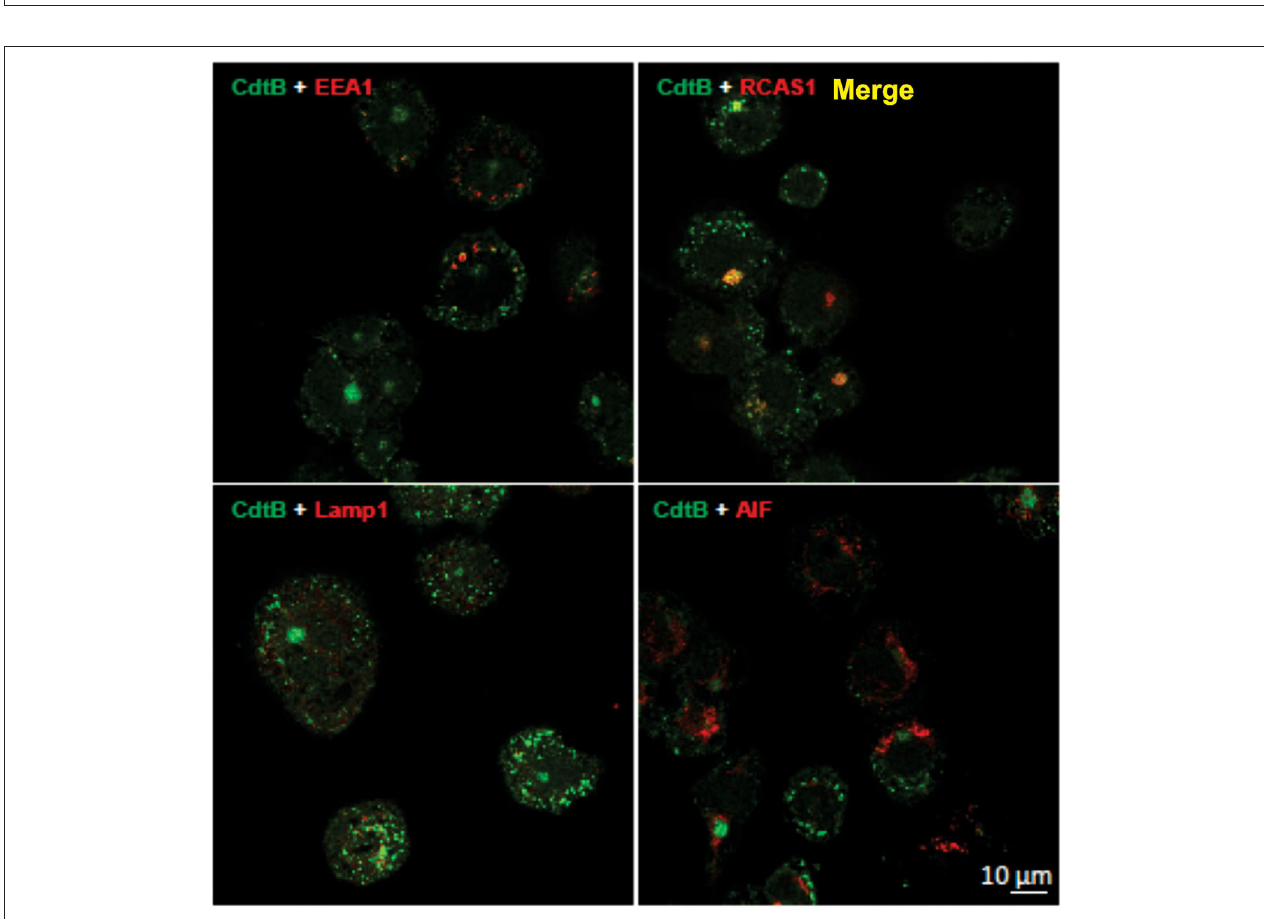
FIGURE 1 | associated with lipid rafts in Cdt treated cells relative to untreated cells (normalized to total cellugyrin). Dashed horizontal line represents unity. Results are from three experiments (4–7 fields per experiment); p < 0.05 (two-tailed one sample t -test). The degree of overlap between cellugyrin and lipid raft staining was